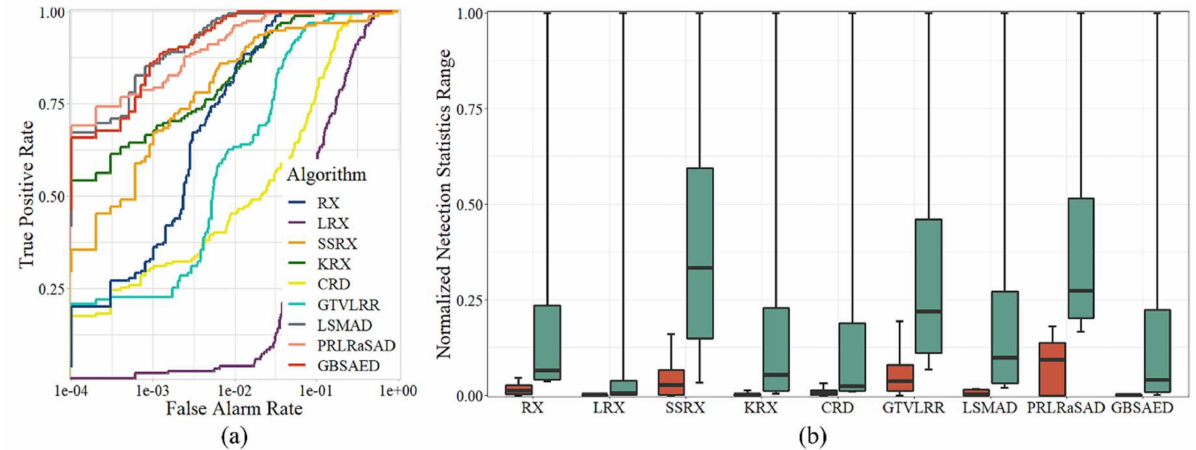
Figure 6. Quantitative analysis of the detection results of the various algorithms for the Texas Coast Image: ( a ) ROC curves and ( b ) target-background separation map.